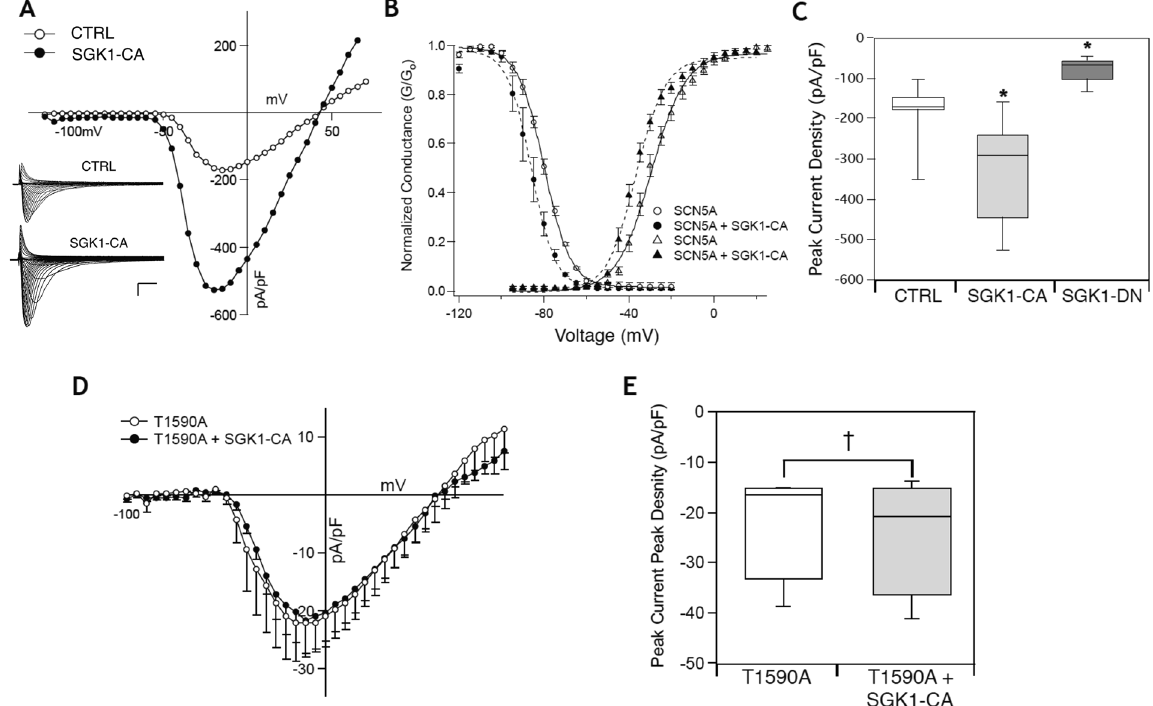
Figure 4. SGK1 regulates Na V 1.5 channel function. ( A ) Expression of SGK1-CA in HEK-Na V 1.5 cells leads to increase in I Na density. Inset scale = vertical: 50 pA/pF, horizontal: 2 ms. ( B ) SGK1 activation leads to a hyperpolarizing shift of steady state activation and inactivation curves for I Na . ( C ) Peak sodium currents are increased with expression of SGK1-CA while inhibition of SGK1 by the dominant negative kinase dead SGK-1 (SGK1-DN) leads to decrease in I Na density ( * p-value < 0.005 by one way ANOVA, n = 5–11 for each condition). ( D ) Mutation of a novel SGK1 putative site T1590A leads to abrogation of the increase in I Na with SGK1 activation. ( E ) Quantification of peak sodium currents (NS = non-significant change, n = 3–5 for each